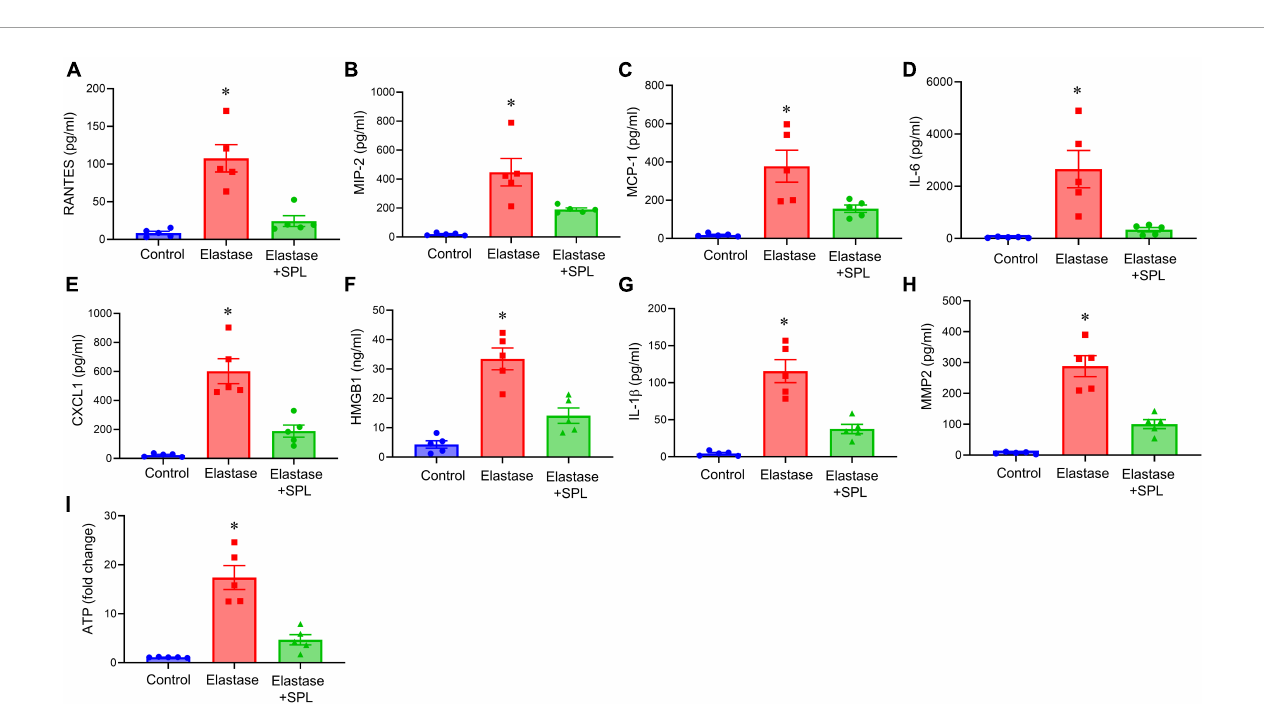
FIGURE3 Aortic inflammation during AAA formation is mitigated by spironolactone treatment. (A–G) Cytokine expression analyzed in the aortic tissue showed a significant mitigation after SPL administration compared to elastase-treated mice alone on day 14. ∗ P < 0.02 vs. respective controls; * P < 0.05 vs. other groups; n = 5/group. (H) SPL-treated mice decreased MMP2 activity in aortic tissue compared to elastase-treated mice alone. ∗ P < 0.001 vs. other groups; n = 5/group. (I) ATP content in aortic tissue was decreased after SPL treatment. ∗ P < 0.002 vs. other groups; n = 5